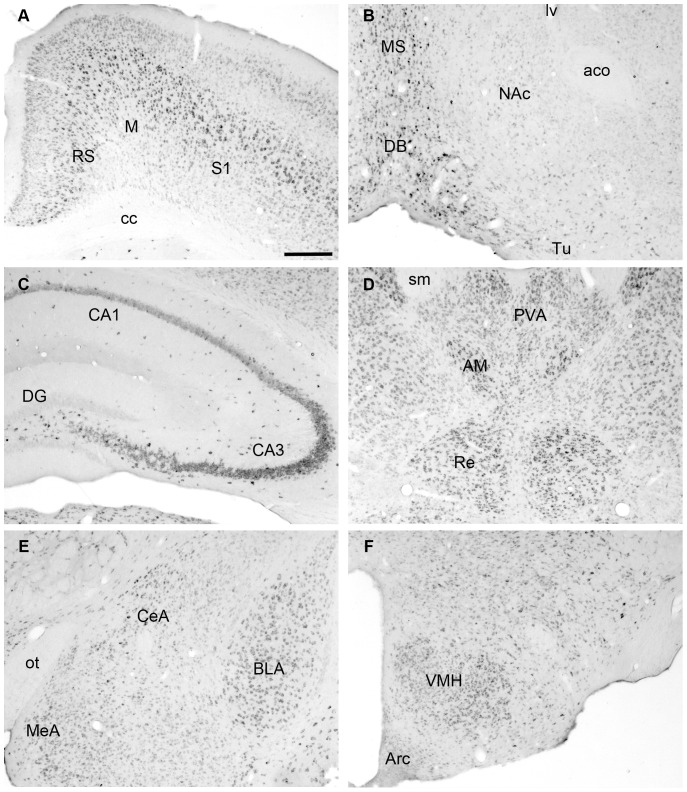
Examples of RUNX2 immunolabeling in the adult mouse brain.RUNX2 immunlabelling in the cortex (A), ventral striatum (B), hippocampus (C), thalamus (D), amygdala (E), and hypothalamus (F) in a representative adult male mouse at CT9. Scale bar indicates 250 µm. Abbreviations: aco: anterior commissure; AM: anteromedial nucleus of the thalamus; ARC: arcuate nucleus; BLA: basolateral nucleus of amygdala; cc: corpus callosum; CeA: central nucleus of amygdala; DB: diagonal band of Broca; DG: dentate gyrus; lv: lateral ventricle; M: motor cortex; MeA: medial nucleus of amygdala; MS: medial septum, NAc: nucleus accumbens; ot: optic tract; PVA: paraventricular thalamic nucleus, anterior; Re: reuniens thalamic nucleus; RS: retrosplenial cortex, S1: somatosensory cortex; sm: stria medularis; Tu: olfactory tubercle; VMH: ventromedial nucleus of hypothalamus.